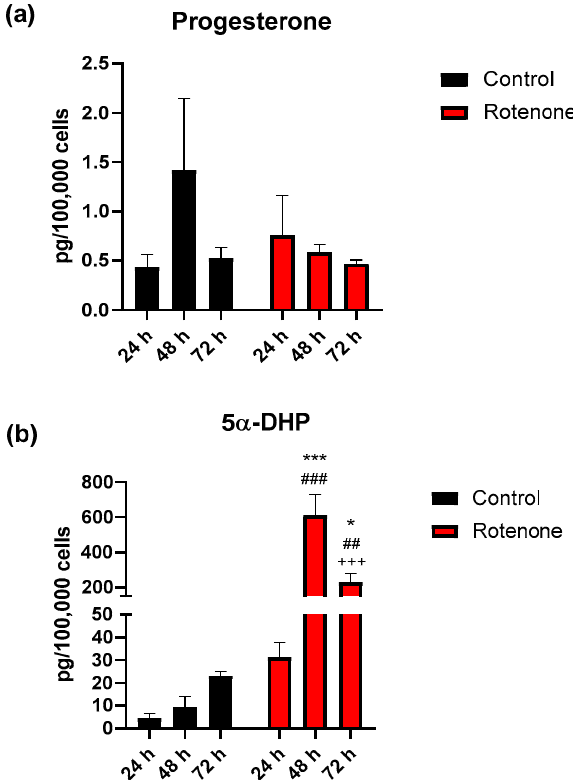
Figure 5. Progesterone ( a ) and 5 α -dihydroprogesterone (5 α -DHP) ( b ) levels in BV-2 cells’ medium determined by LC-MS/MS in microglia, in resting condition (Control) or after activation by exposure to rotenone at different time intervals (24, 48 and 72 h). Data represent the average of 2 independent experiments ( n = 5) and are expressed in pg/100,000 cells (mean values ± SEM). Statistical analysis was by two-way ANOVA and Holm-Šídák post-hoc test. 5 α -DHP: *** p < 0.001, * p < 0.05 vs 24 h rotenone; +++ p < 0.001, vs 48 h rotenone; ### p < 0.001, ## p < 0.01, vs same time interval of control.